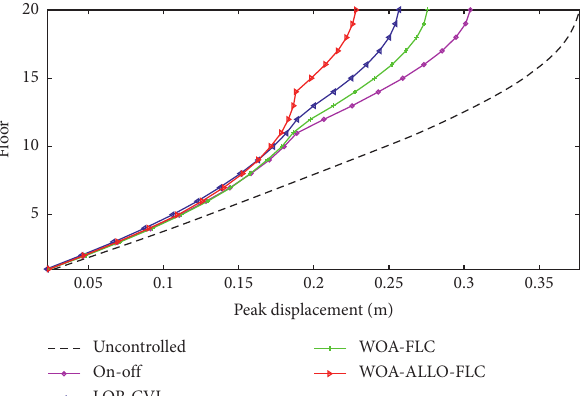
Figure 7: Comparison of the peak displacements of Building 1 among different control methods.